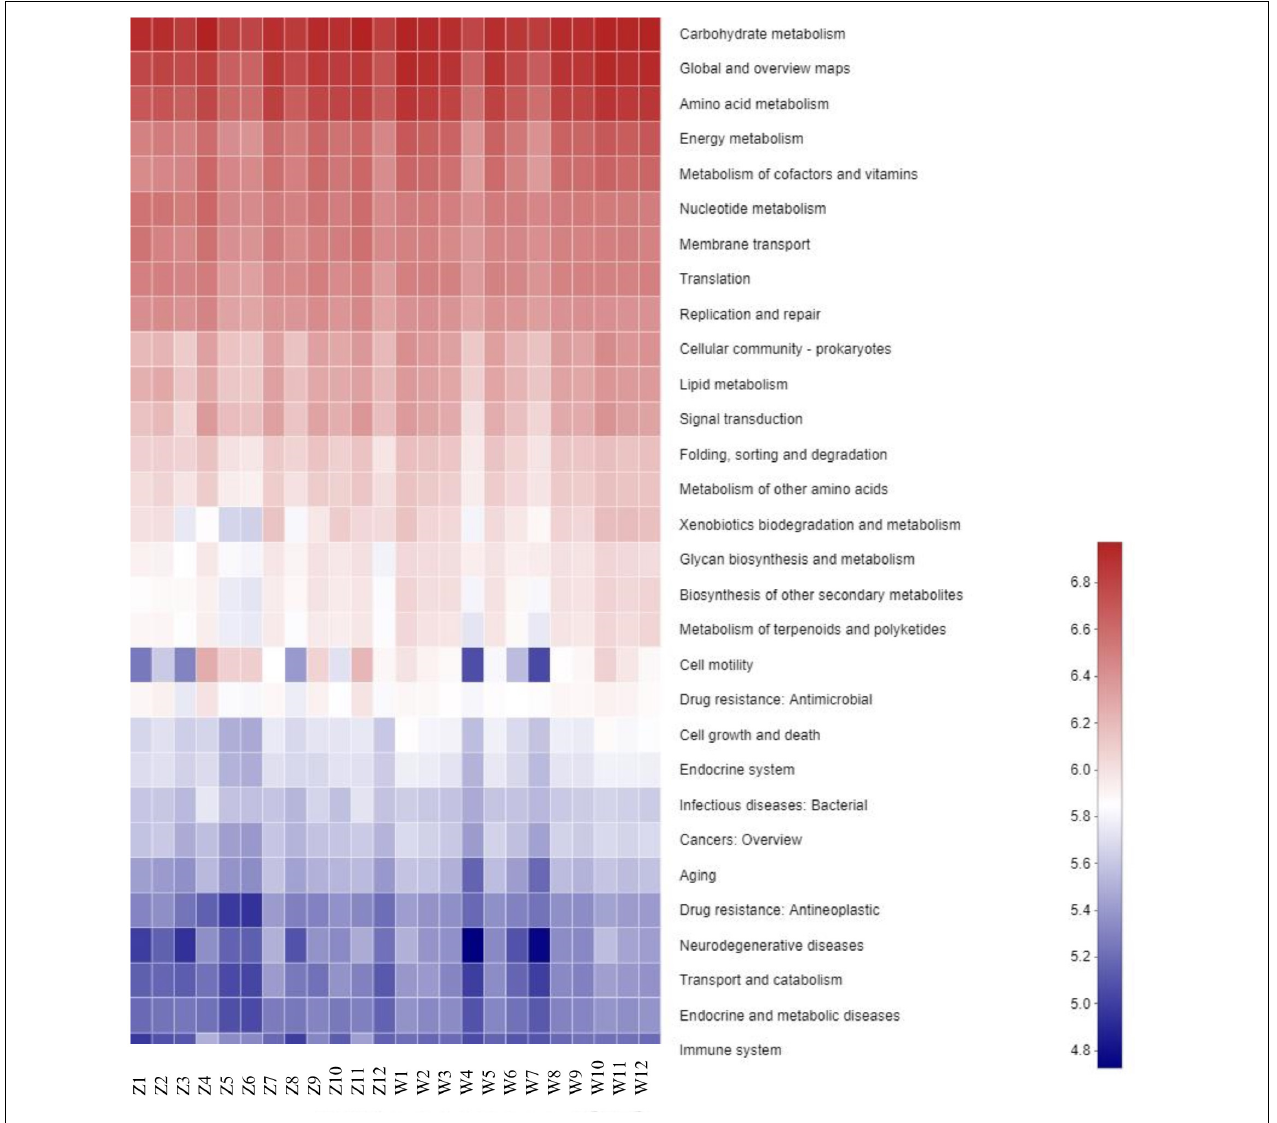
FIGURE 5 | Heatmap of predictive KEGG functions in each